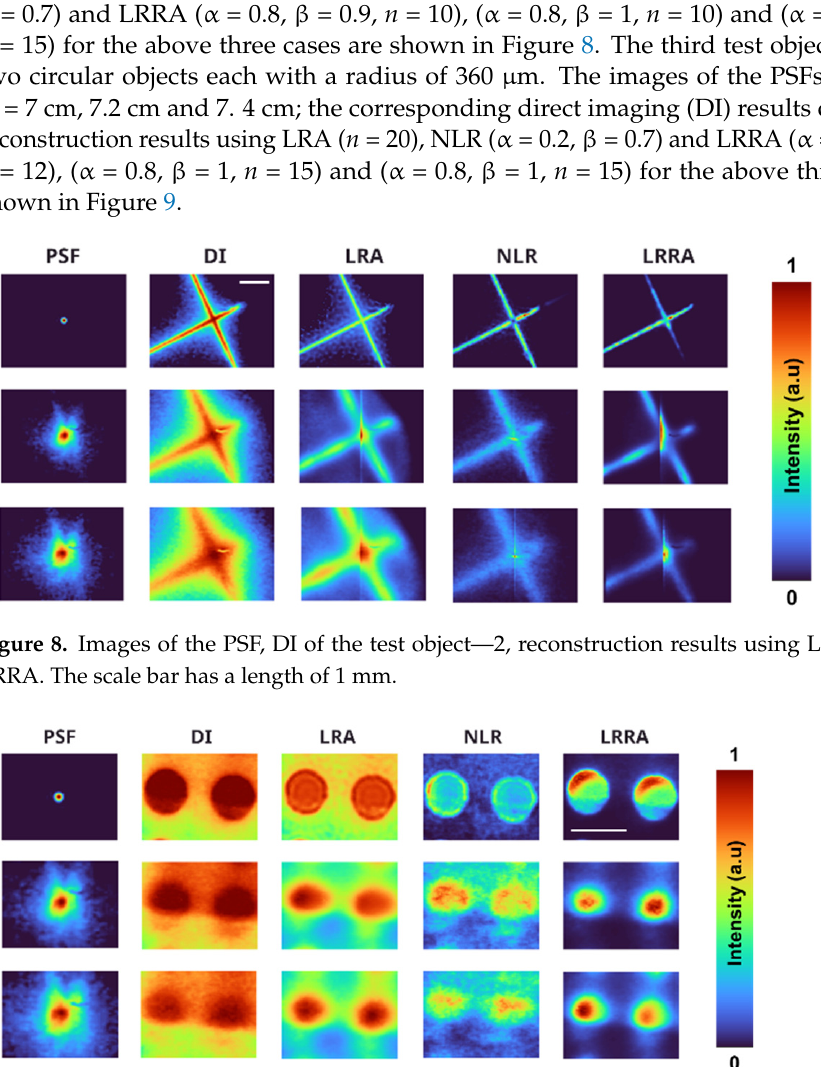
Figure 9. Images of the PSF, DI of the test object—3, reconstruction results using LRA, NLR and LRRA. The scale bar has a length of 1 mm.